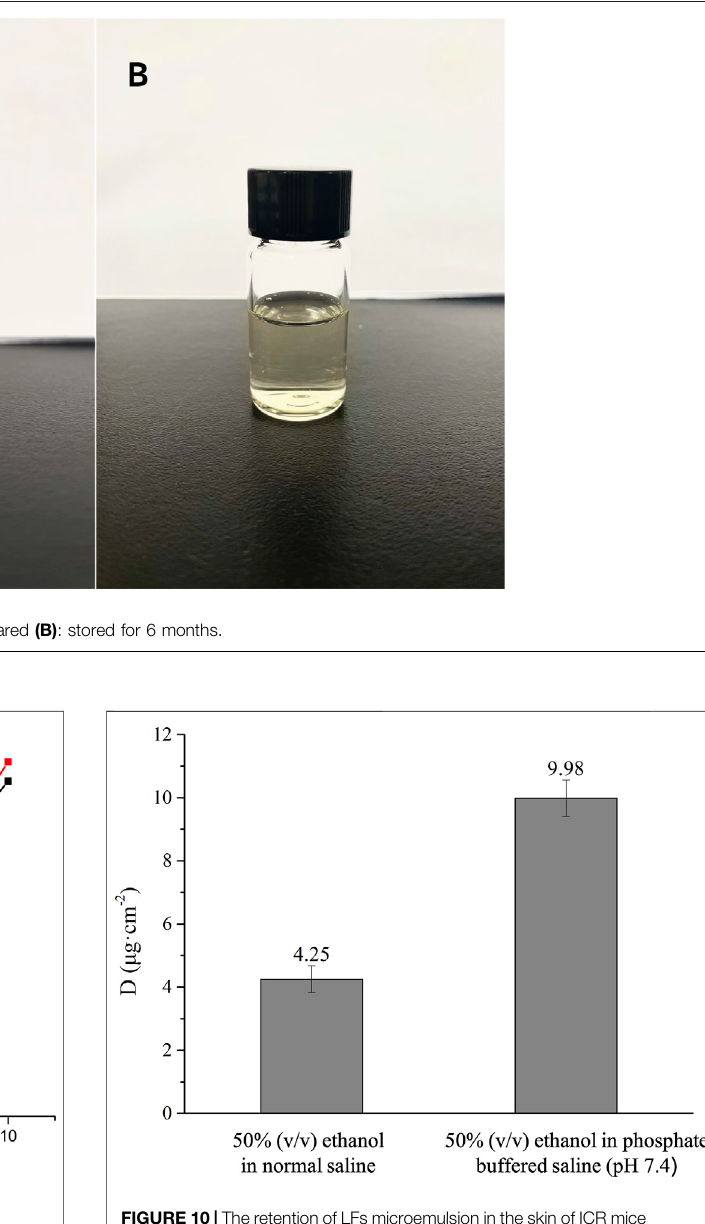
TABLE 8 | Comparison of in vitro transdermal performance of two different receptor fl uids. Receptor fl uid